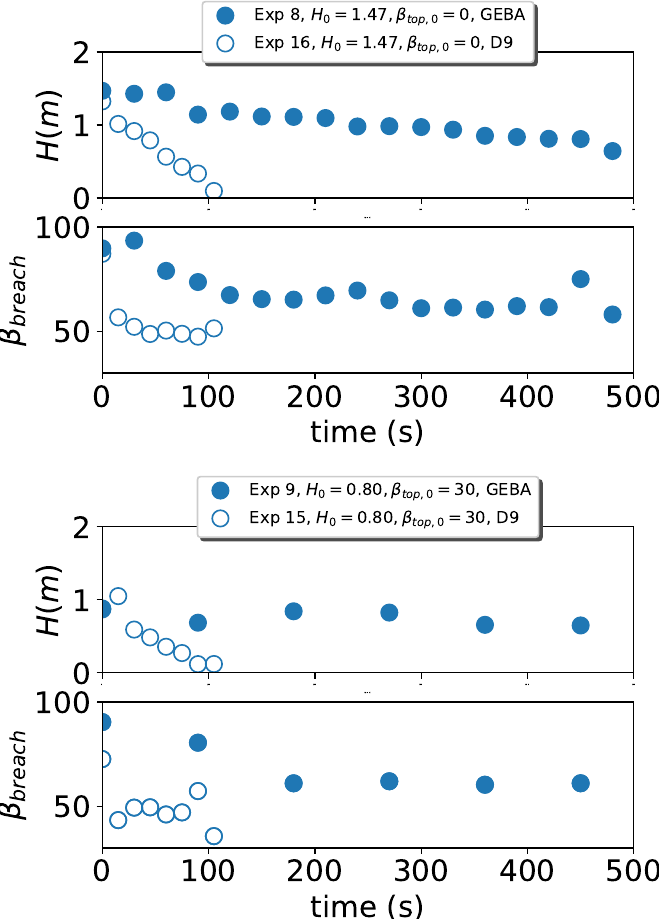
Figure 11. Effect of sand type on the temporal evolution of the breach height, H , and breach face angle, β breach